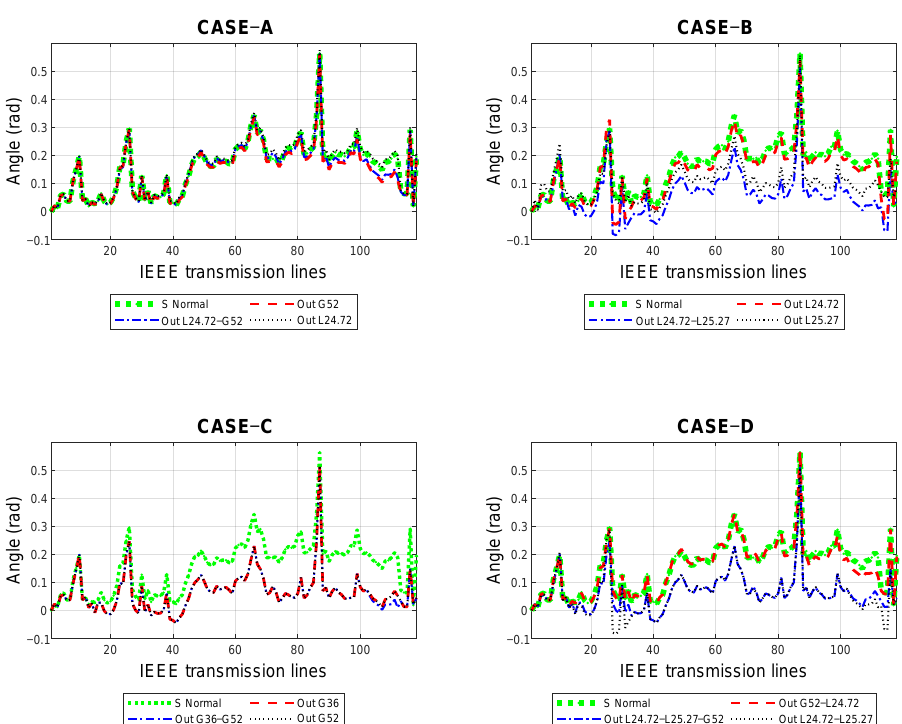
Figure 5. Angular deviation in the IEEE 118 system bus bars subjected to